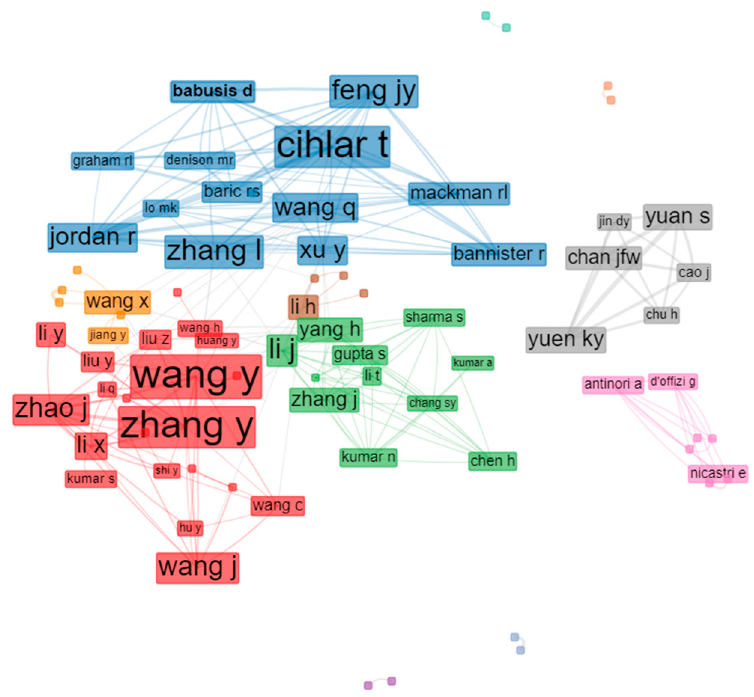
Figure 5. Visualization of academic collaboration between the authors.